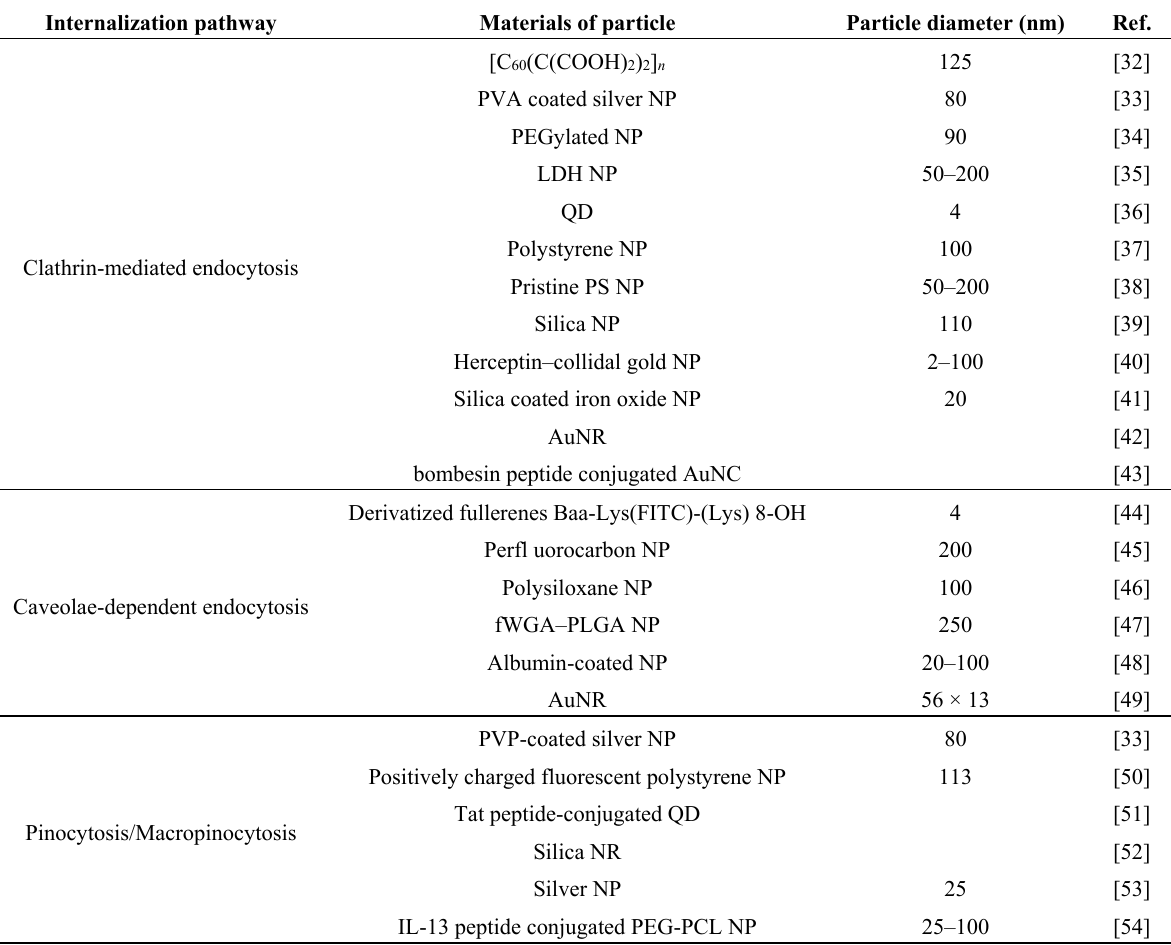
Table 2. Examples of cellular internalization pathways of